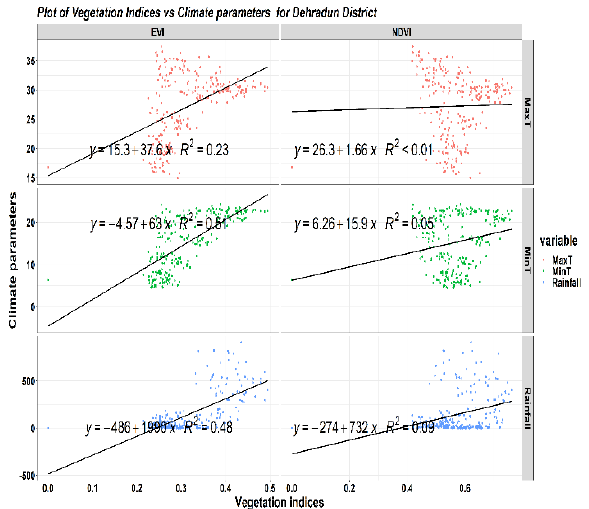
Figure 14. Scatter Plot between Vegetation Indices and Climate Parameters for Dehradun